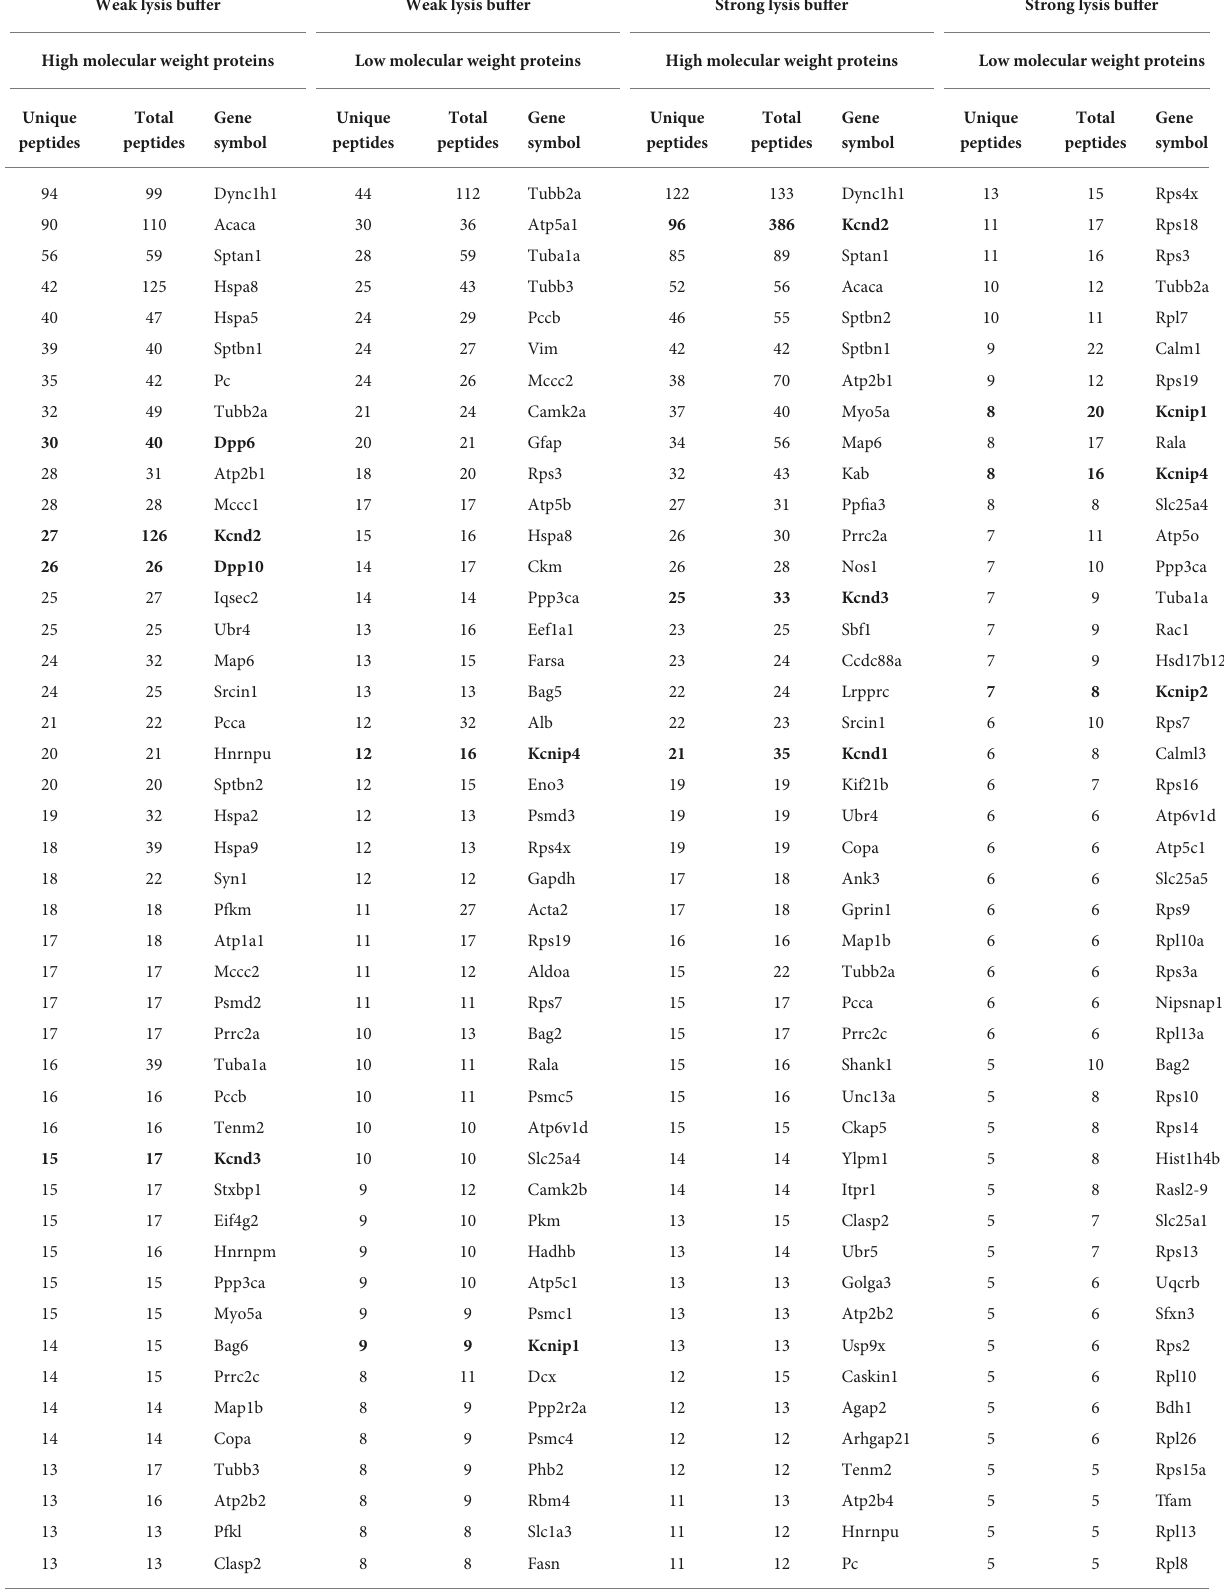
TABLE 1 Candidate proteins that were identified by TAP-MS in hippocampal neurons. Weak lysis